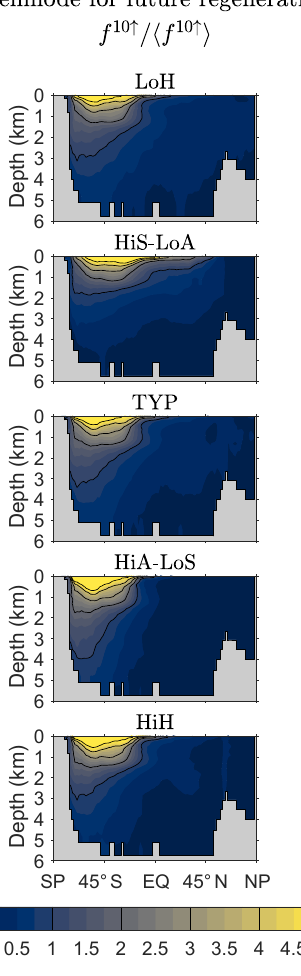
Figure 9. Global zonal averages of f 10 ↑ normalized by their global means, (cid:104) f 10 ↑ (cid:105) , to show the approximate asymptotic eigenpatterns for five representative state